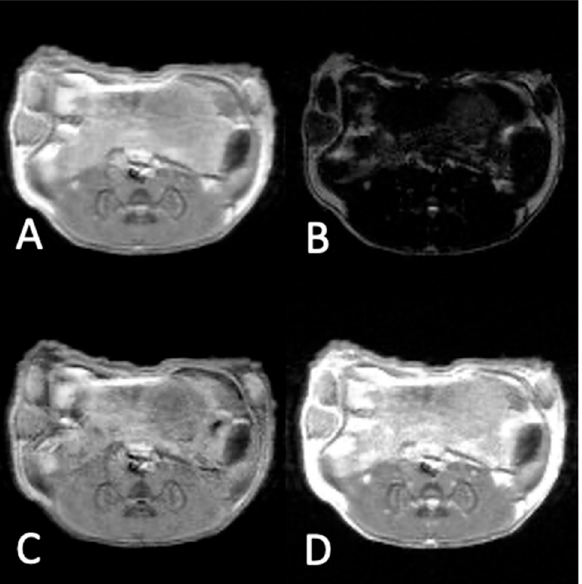
Figure 7. MR images of a mouse bearing TNB tumor pre-injection of the NaDyF 4 /NaGdF 4 contrast agent: ( A ) T 1 w. ( B ) T 2 w. ( C ) Image obtained by the subtraction of ( B ) from ( A ). ( D ) Image obtained by the addition of ( A , B ). The highest contrast is obtained in image ( C ) and is equal to TC = 1.52. Table 2. The values of S tu , S ti , and TC pre- and 15 min post-injection of non-targeted NaDyF 4 /NaGdF 4 contrast agent obtained from the images in Figures 7 and 8. The highest tumor contrast is observed for subtracted images both before and after